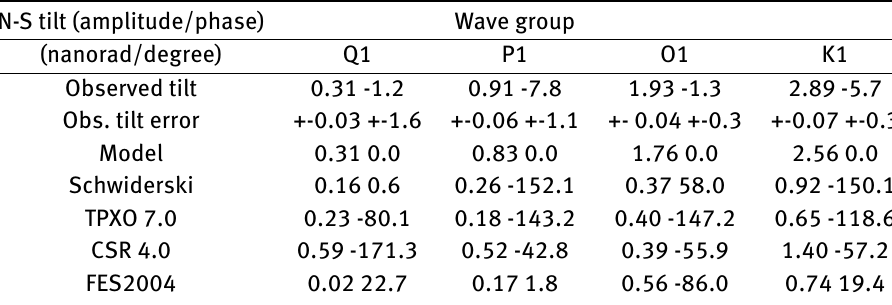
Table 1: Amplitude and phase values of the observed N-S earth tide tilt, earth tide model tilt and ocean loading model tilt for Q1, P1, O1 and K1 tidal potential wave groups.